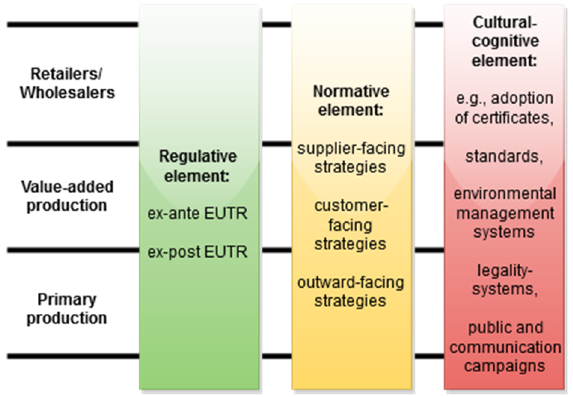
Figure 1. The conceptual framework considering the institutional elements of forest and CoC certification strategies and practices. The analysis is implemented ex ante and ex post the EUTR and at the different stages of value